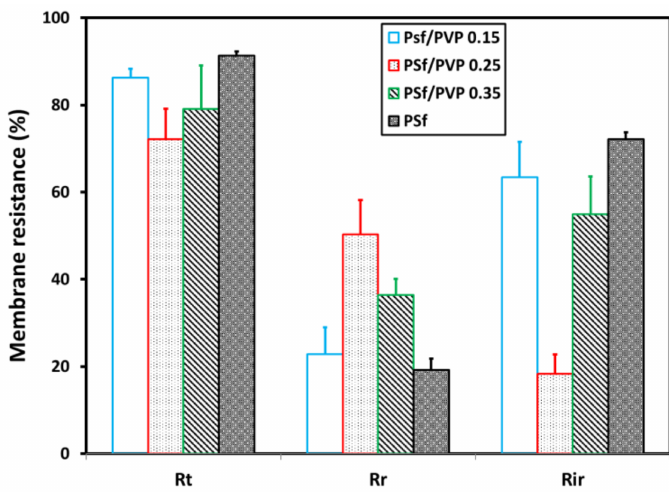
Figure 11. Membrane fouling comparison of various membranes.